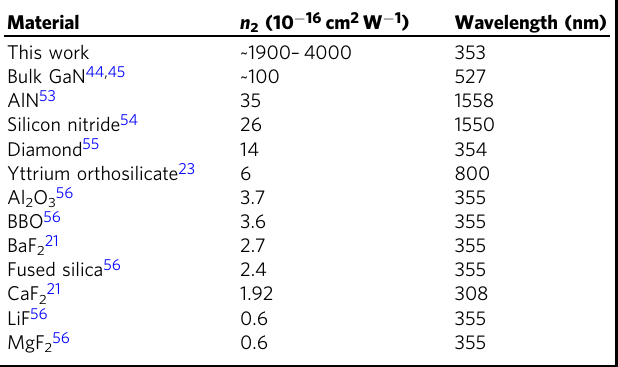
Table 1 Nonlinear refractive indexes of materials commonly used for nonlinear optics with UV pulses.